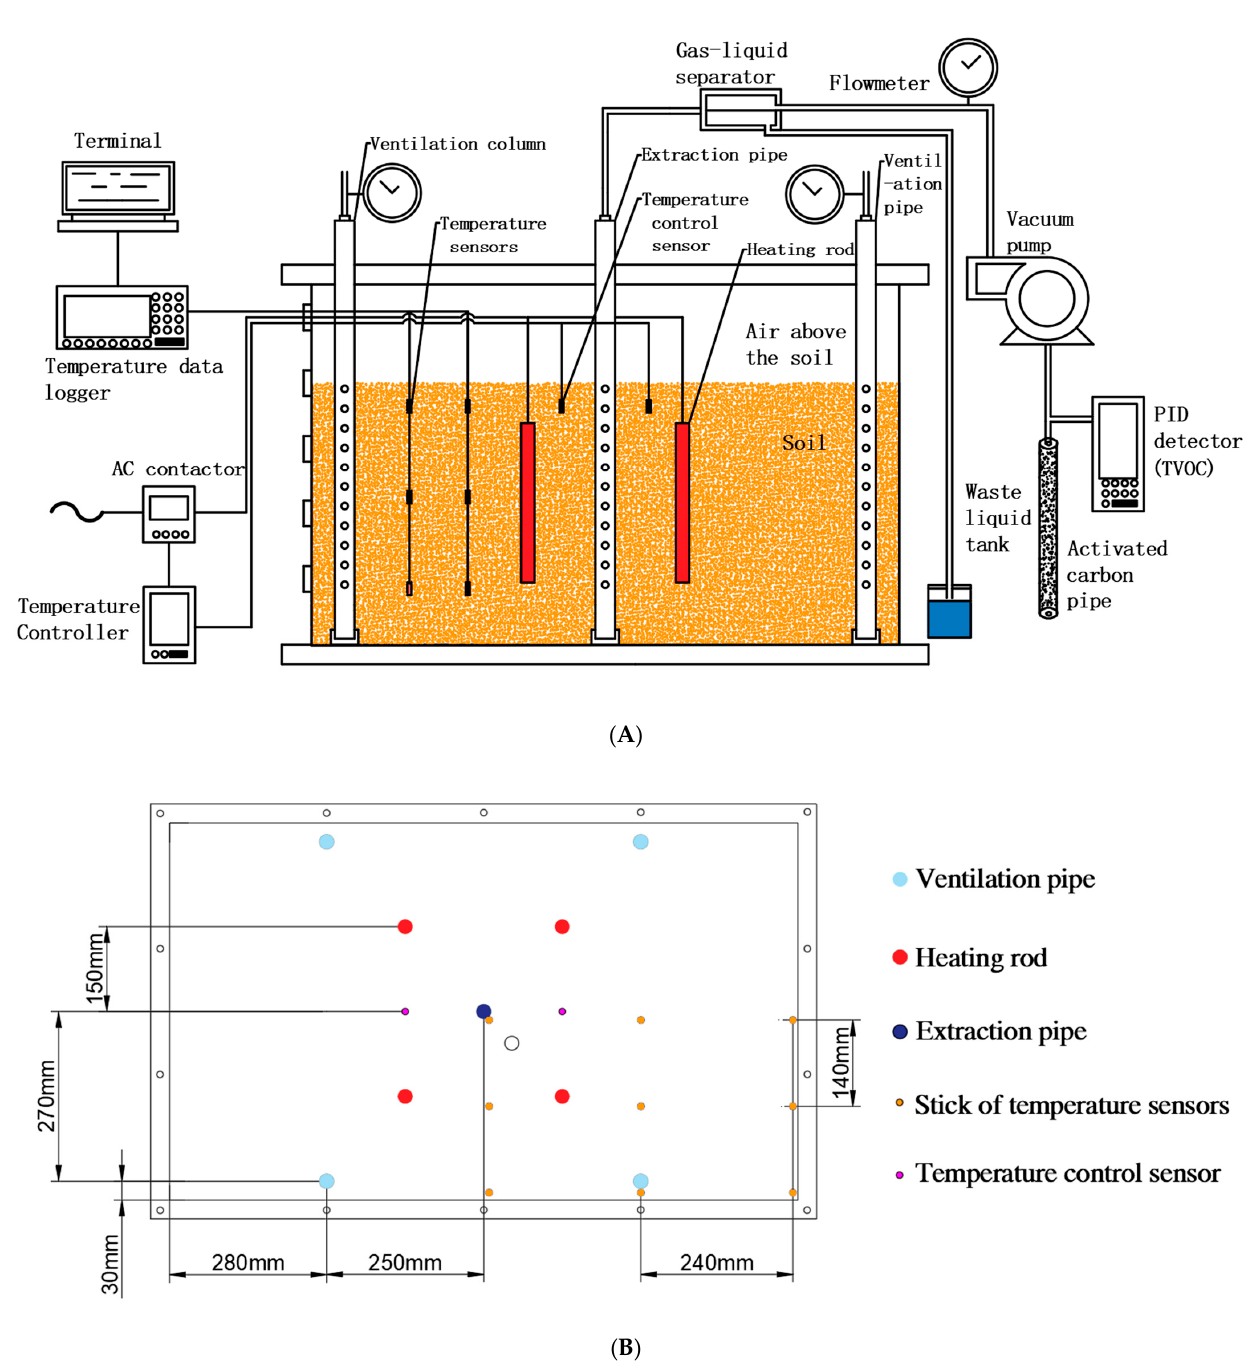
Figure 1. Schematic diagram of each unit setting ( A ). Plane distribution of each component ( B ).